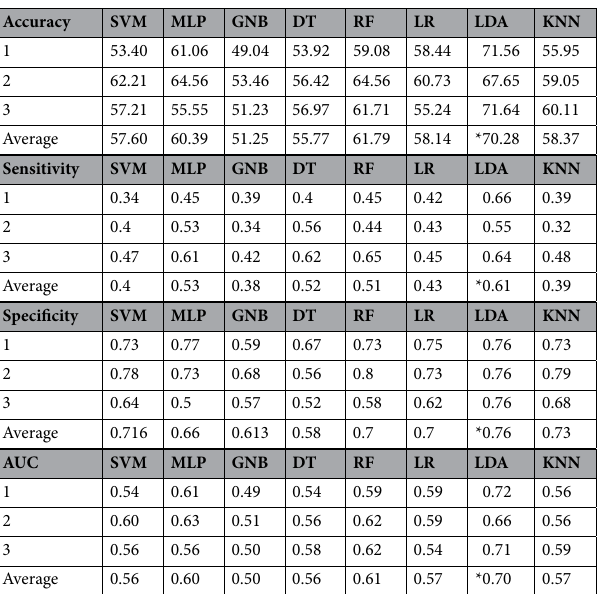
Table 3. Results of ML analysis (eight methods) of BPW indices for discriminating between robust and possible sarcopenia (dynapenia + presarcopenia + sarcopenia). The accuracy is in %. Values are for threefold cross-validation. Asterisks indicate the highest average value. Accuracy, sensitivity, specificity and AUC were all highest for LDA.